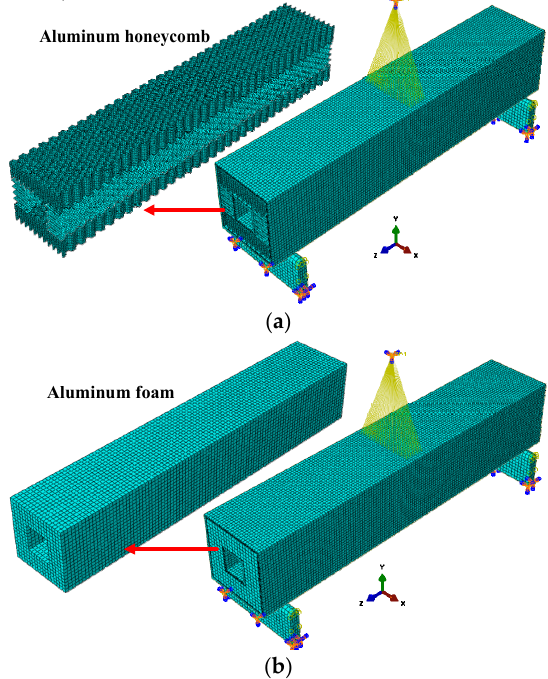
Figure 12. Finite element models of composite sandwich laminated box beams. ( a ) Aluminum honeycomb core; ( b ) Aluminum foam